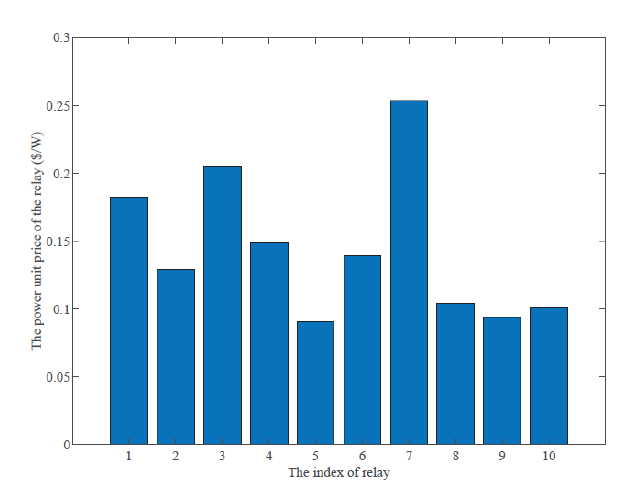
Figure 6. The power unit price of